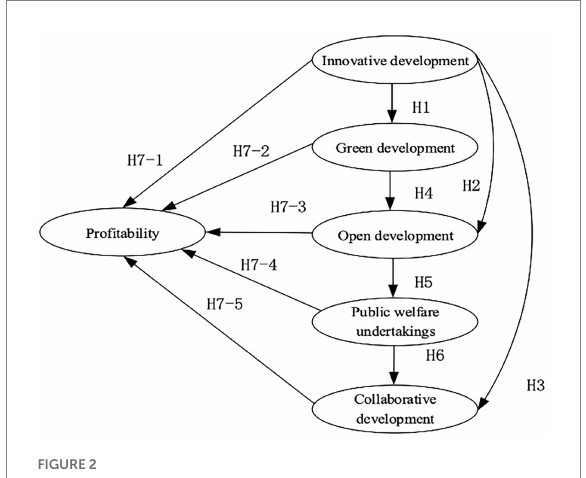
FIGURE 2 Framework of the relationship between the dimension of high quality development and corporate profitability.